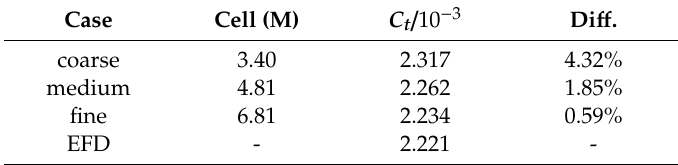
Table 8. The total resistance coe ffi cients of di ff erent grids of the full-scale KCS. Case Cell (M) C t / 10 − 3 Di ff .